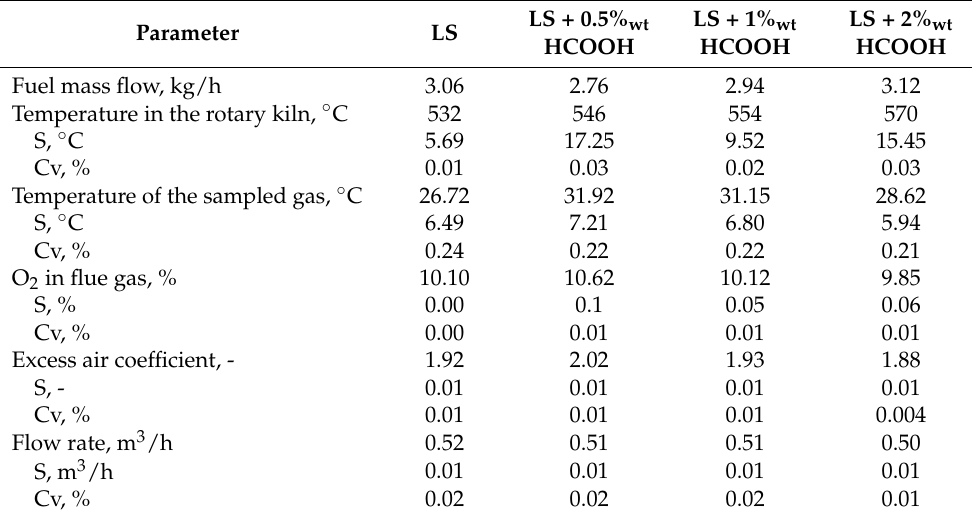
Table 2. Fuel combustion parameters in 44 kW rotary kiln.